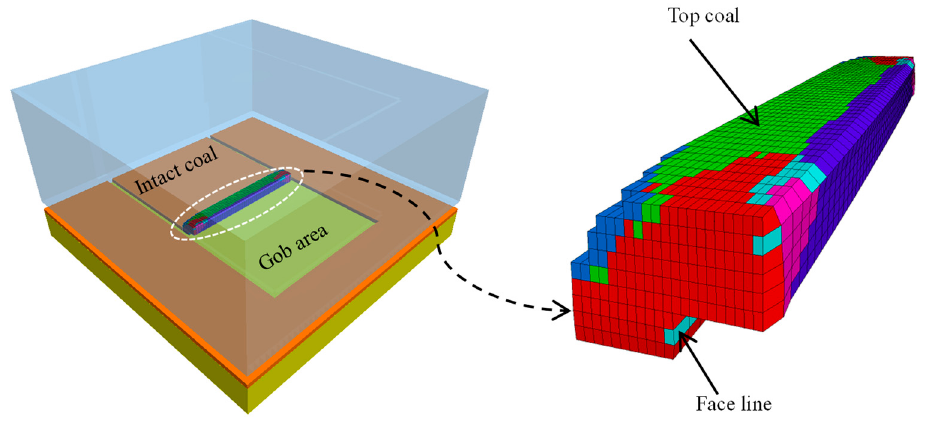
Figure 10. Failure zone of top ‐ coal at 100 m of face